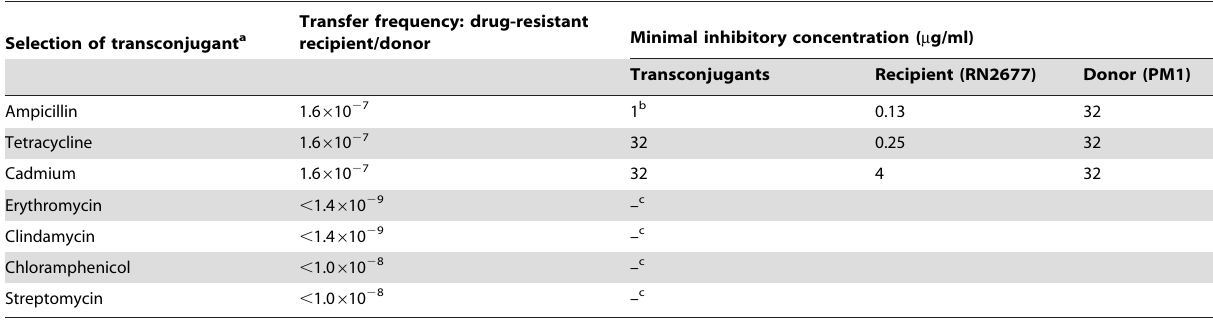
Table 2. Transfer of drug resistance in mating between ST59 CA-MRSA strain PM1and S. aureus RN2677.